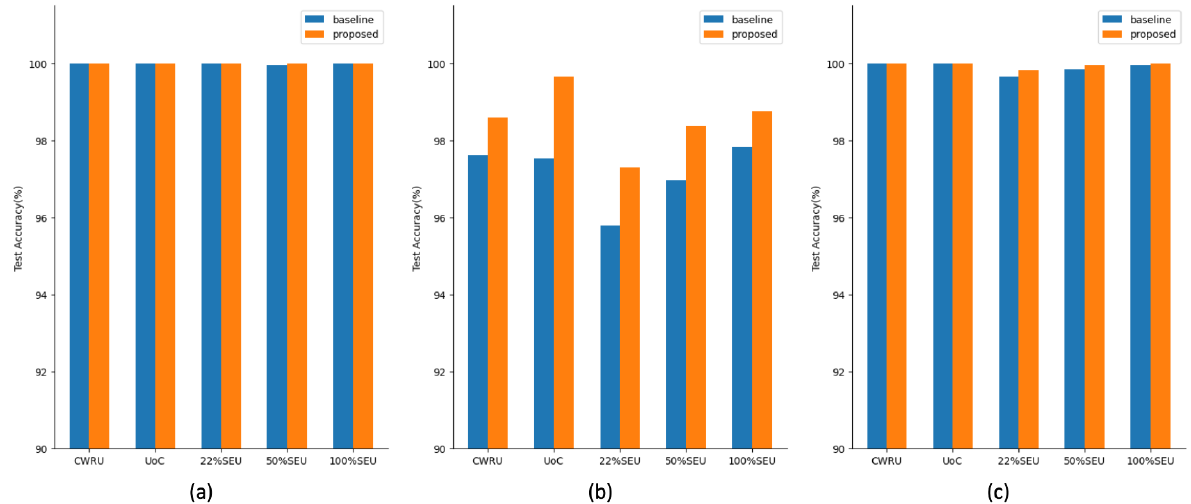
Figure 8. Performance comparisons: ( a ) tests on original datasets, ( b ) tests on datasets with noise, and ( c ) tests on datasets with trend